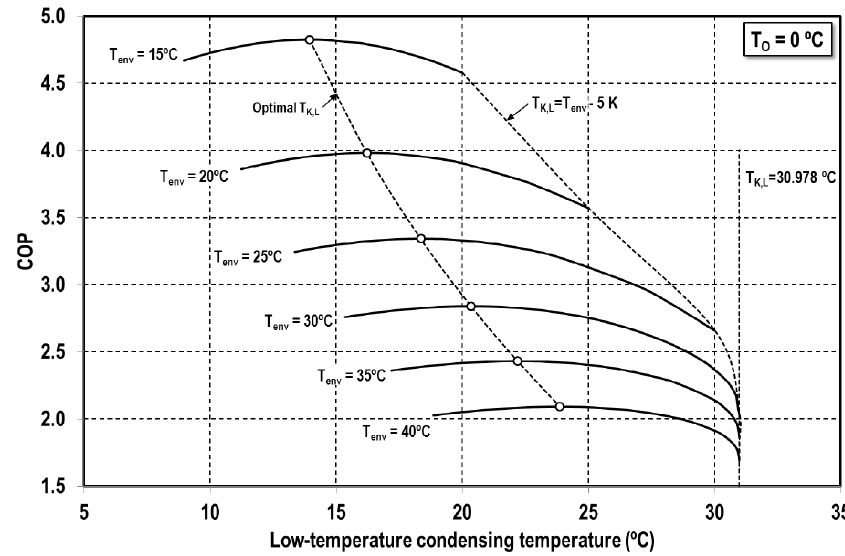
Figure 9. COP dependence on the low ‐ temperature condensing temperature of cascade system. (T o = 0 °C).